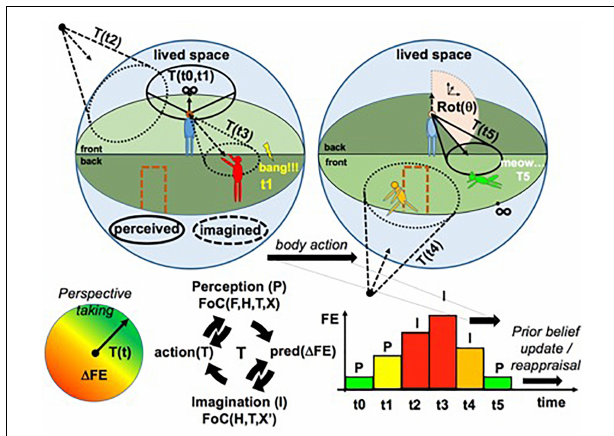
FIGURE 4 | Overall sketch of the PCM. Lived space S (represented by blue spheres): subjective experience of space and its contents as perceived (continuous funnels on the figure) or imagined (dashed funnels), framed in a 3-dimensional projective representation in perspective of a world model R ( X, t ) associated with a distribution of Free Energy (FE), related to cognitive and affective personal preferences (colors on the manikins and door, and disk with color gradient). Perspective taking and the selection of corresponding projective transformations T are constrained by the gradient of FE across space δ FE. The diagram with the arrows in a circle represents the possible transitions of state affecting the FoC: form perception to imagination and action. The FoC is partially driven by sensory evidence when it is focused on perception of the local environment and entirely driven by prior beliefs in memory and simulation capabilities when it is focused on imagination of non-local spaces (e.g., when we imagine ourselves at home while we are at work). FE minimization defines the optimal perspective at a given instant. FE is globally minimized through cycles of perception, imagination, and action across time. The bar graph represents FE as a function of time and of the different perspectives and processing modes [P—perception versus I—(non-local) imagination] adopted by the system (see text and Rudrauf et al., 2017; image from Rudrauf et al., 2017, used by permission from